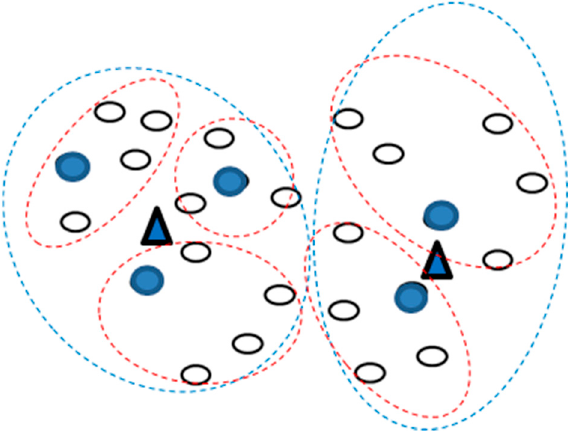
Figure 3. Selection of the optimal number of clusters for all SMs with one DAP.